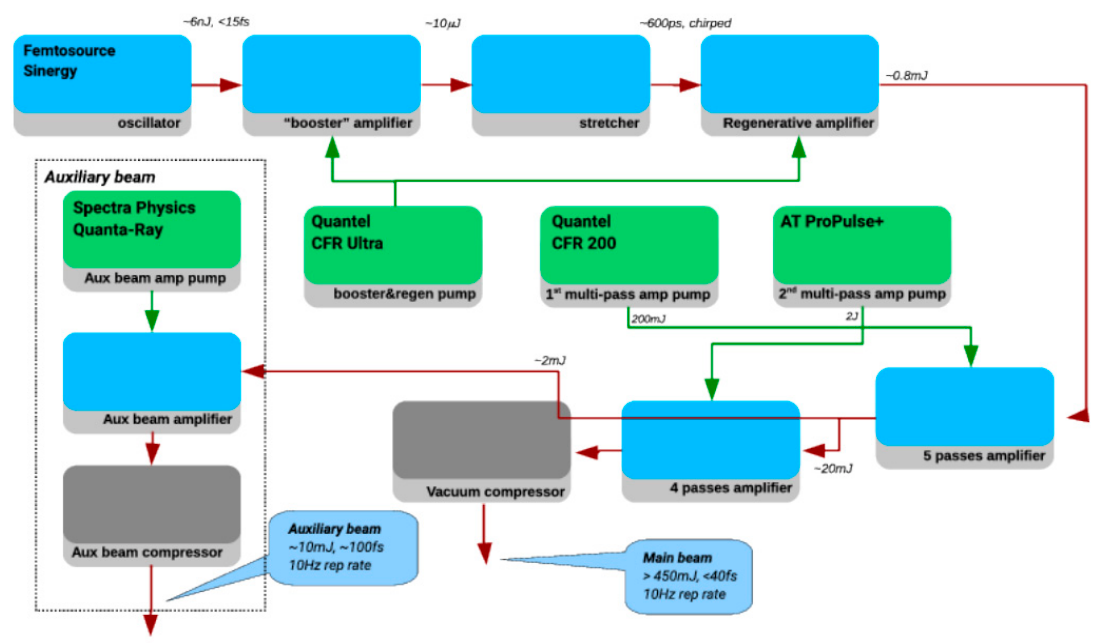
Figure 2. Schematic view of the laser front-end, including the 10 TW compressor.